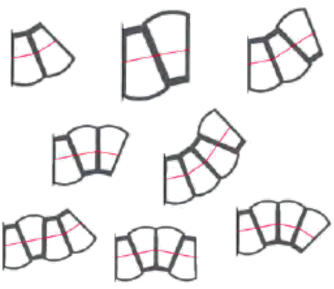
Figure 10. Examples of multiple-unit groups found using MCMC methods. The red centre lines show the response of an initially straight reduced-order model to applied pressure. The wedge shape of the inflated bending unit is included for